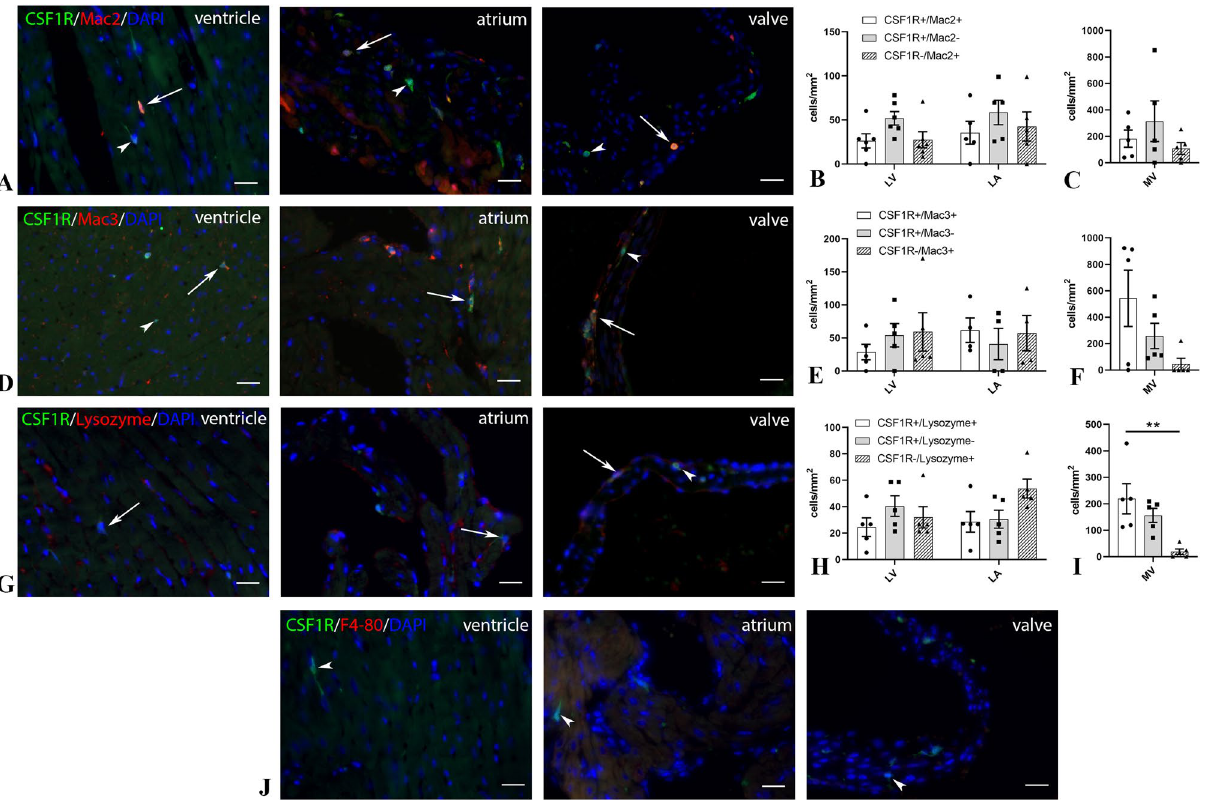
Figure 6. Identification of macrophages in the normal heart using CSF1R-EGFP reporter line and macrophage antibodies. Dual fluorescence for GFP and macrophage antibodies in heart sections from CSF1R-EGFP mice. CSF1R+ cells are sparsely distributed throughout the left ventricle (LV), and left atrium (LA), but exhibit a higher density in mitral valve leaflets. Only a small fraction of CSF1R+ cells express Mac2 ( A – C ), Mac3 ( D – F ), or LyzM (stained with anti-lysozyme antibody, clone EPR2994(2)) ( G – I ) (arrows). F4-80 (ab111101) does not stain any myocardial cells ( J ). Scale bar: 20